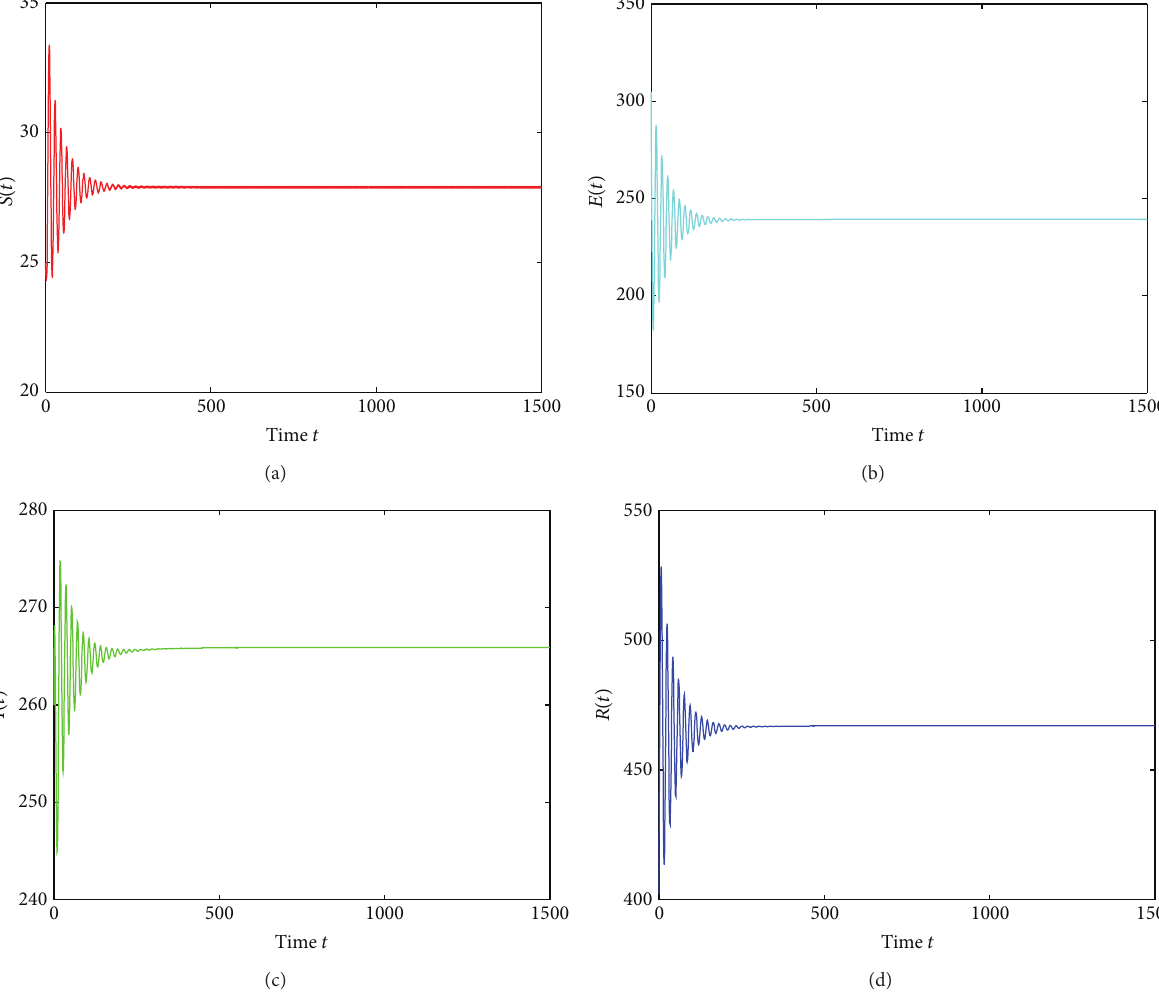
Figure 9: The track of the states 𝑆 , 𝐸 , 𝐼 , and 𝑅 for 𝜏 = 4.7500 < 5.1094 = 𝜏 0